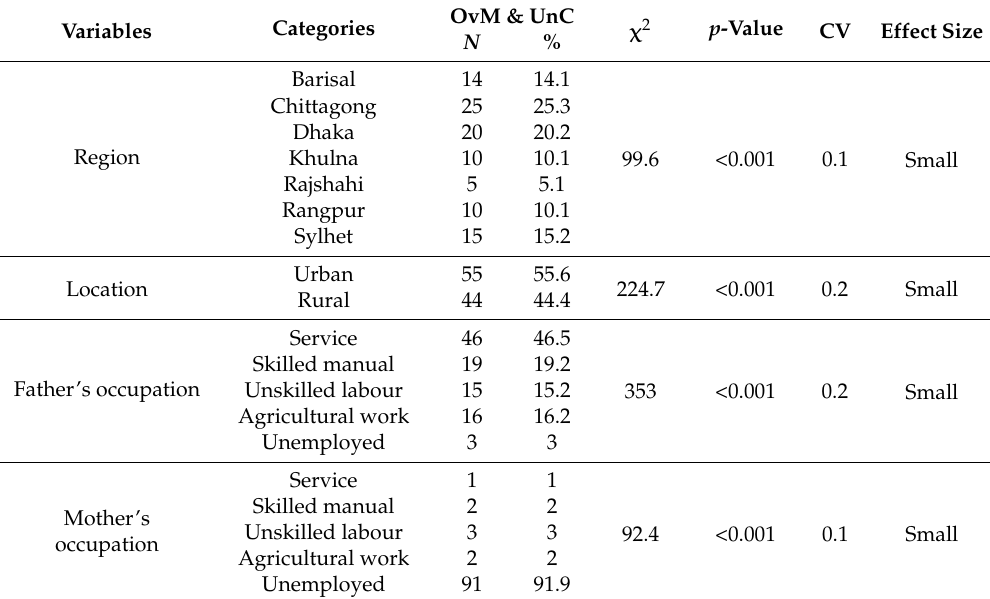
Table 3. Prevalence of overweight mothers and underweight children through socio-demographic